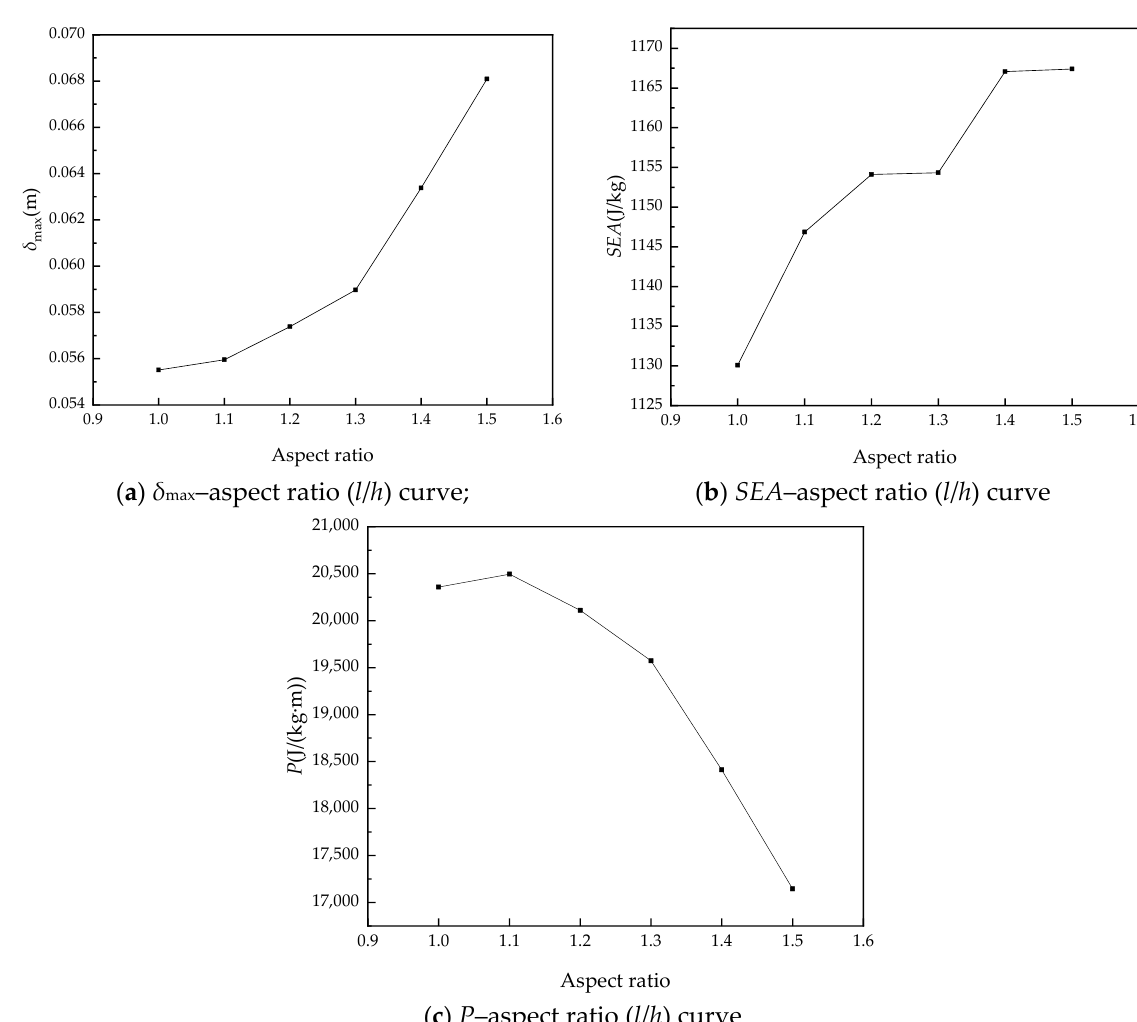
Figure 19. The curve of anti-blast index and different aspect ratio ( l / h ).